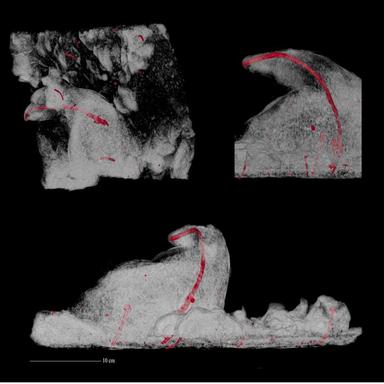
CT images, the metal elements inside the body of the eagle are shown in red.